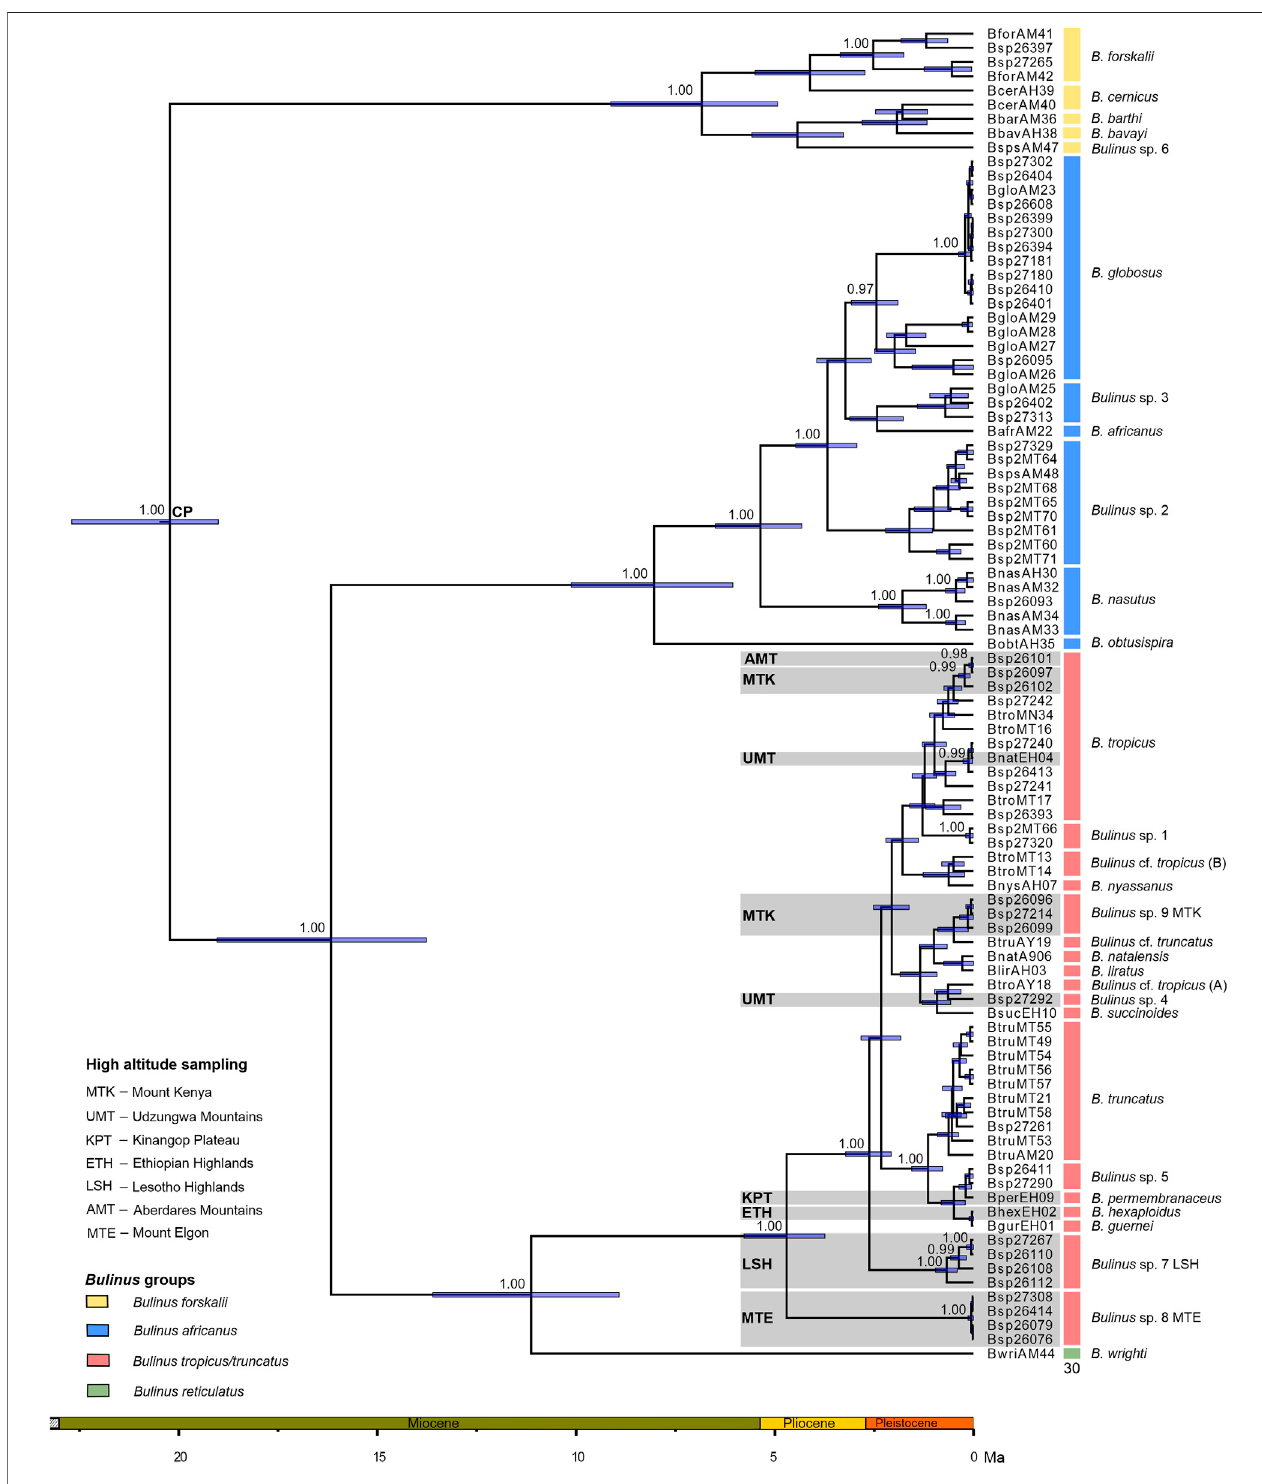
FIGURE 2 | BEAST MCC tree with the posterior probabilities above 0.95 given. 95% highest probability densities (blue bars) and the calibration point (CP) are provided. The outgroup was removed a posteriori . Specimen details can be seen in Supplementary Table S1 .